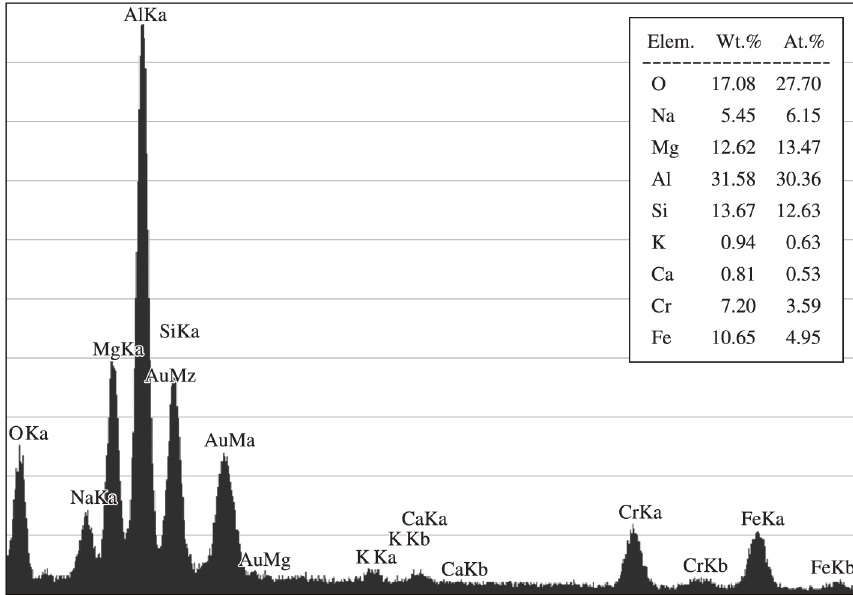
Figure 4. EDS of secondary phase found in the material produced using only granite waste.